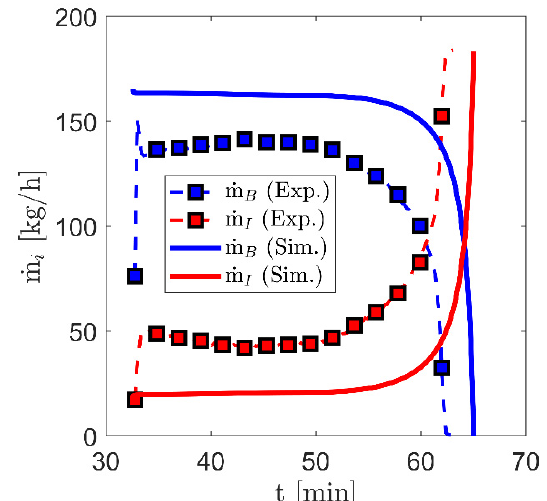
. m B ) and storage